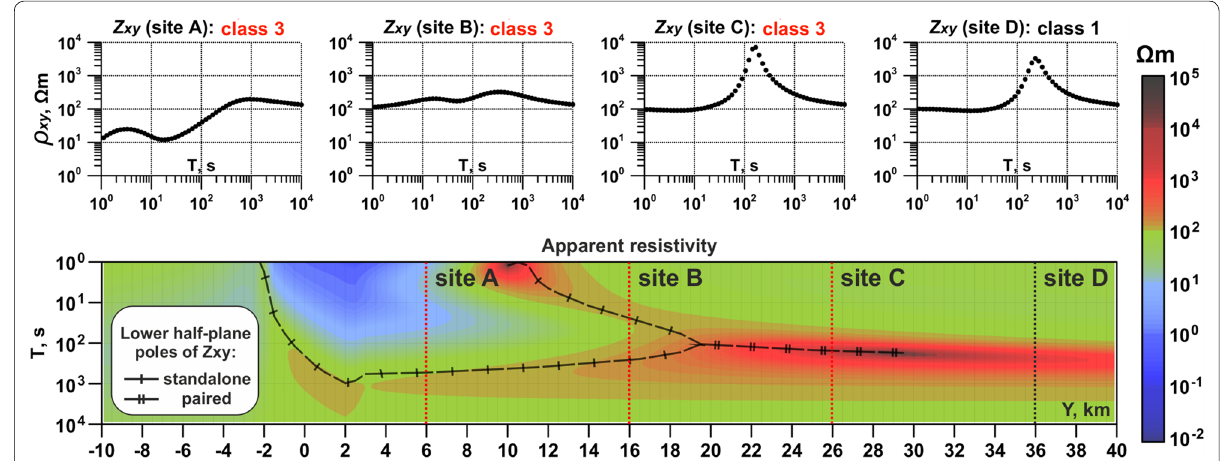
Fig. 10 The apparent resistivity ρ xy curves observed in E-polarized 2-D model of the coast